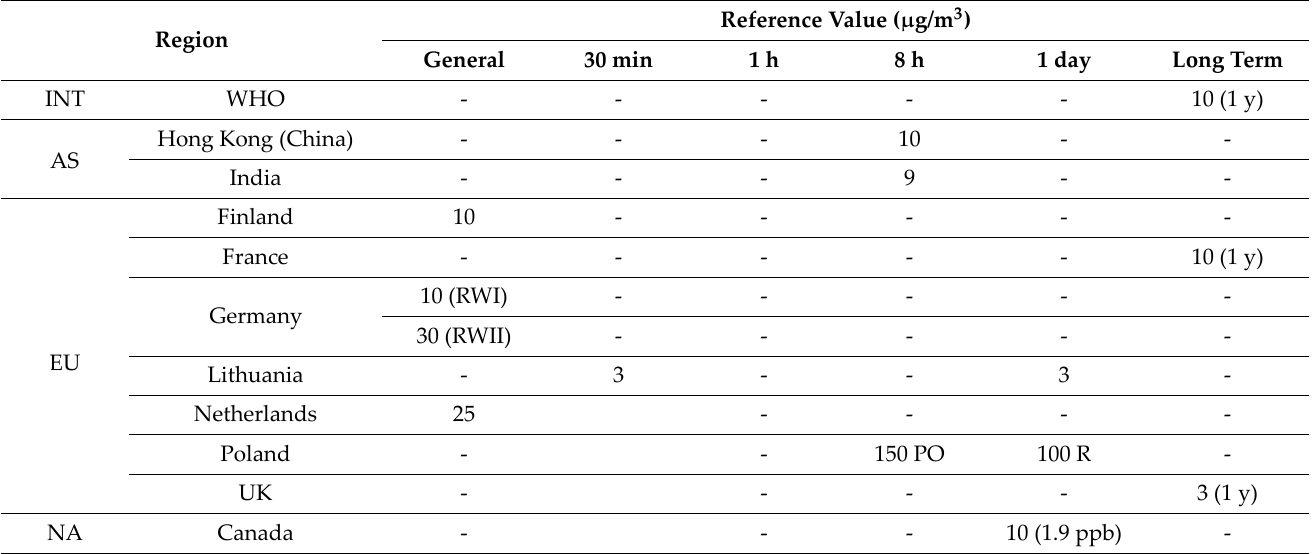
Table 10. Reference values for